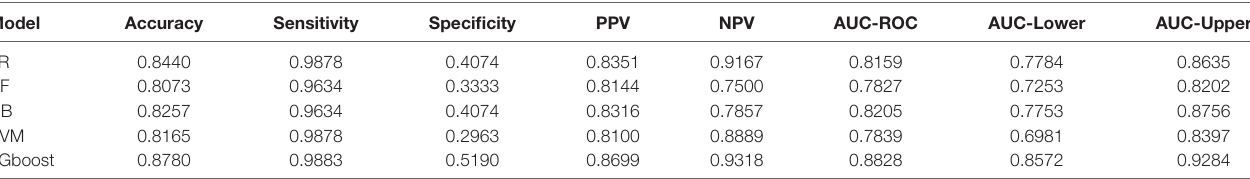
FIGURE 5 | The ROC curves of four machine learning models and the LR model. TABLE 3 | Performance of machine learning